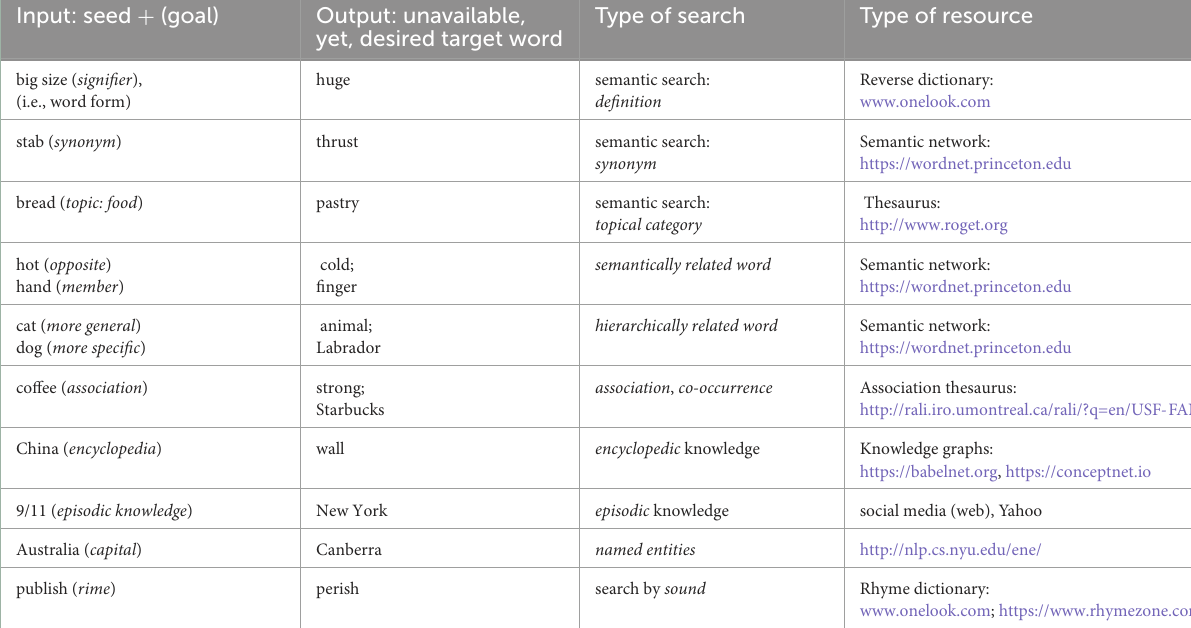
TABLE 1 Potential dialogues between a human and a lexical resource based on the user’s momentary knowledge state. Input: seed +